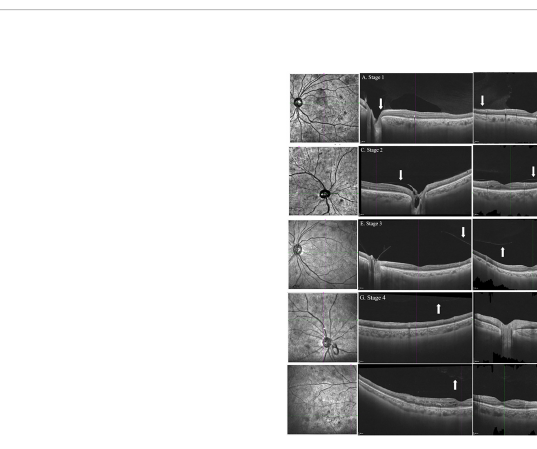
(P=0.413). Figure 4 presents Bland – Altman plots for NPAs. The horizontal lines represent the mean ratio and 95% con fi dence interval limits. According to the Bland – Altman method, the mean ratio of the NPAs measured by WF SS-OCTA to UWFFA